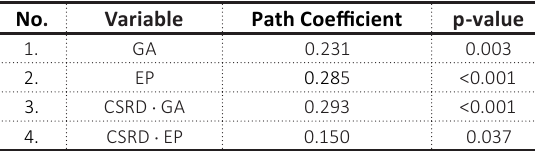
Table 3. PLS path analysis coefficient